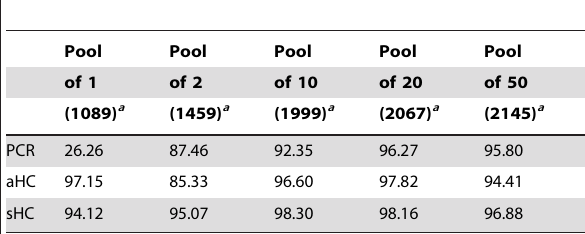
Table 2. HapMap variation detection sensitivity after duplicate removal.